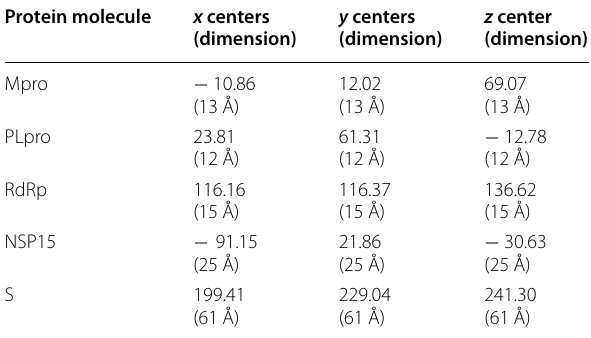
Table 3 Coordinate or the x , y , and z centers of grid boxes of proteins were given in Table 4, and the details of inter- breast cancer proteins with dimensions acting amino acids of proteins with AGP derivatives with the highest binding energy were given in Table 5. Protein molecule x centers (dimension) The interacting amino acids of SARS-CoV-2 proteins with all AGP derivatives and reference drugs were given in Table S1 as supplementary data. The PyRx docking